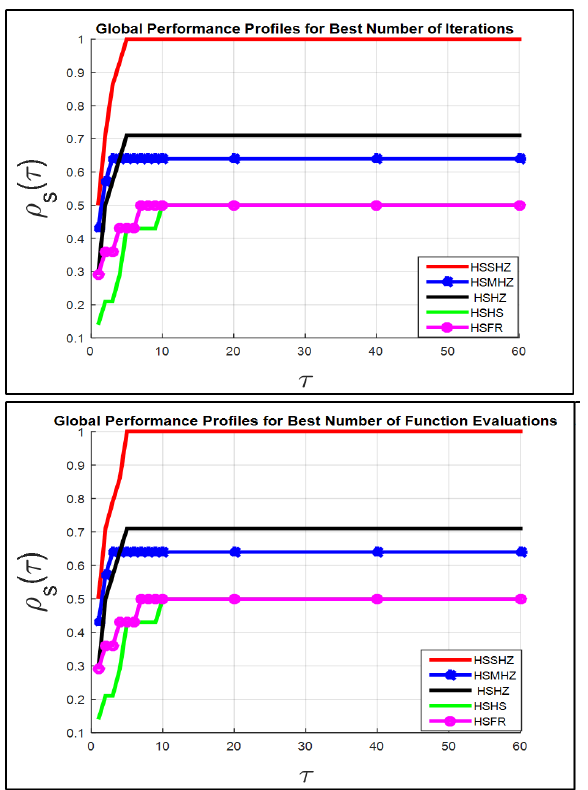
Figure 6. Plotting the results of the terms itr.be and FEs.be for 5 algorithms.